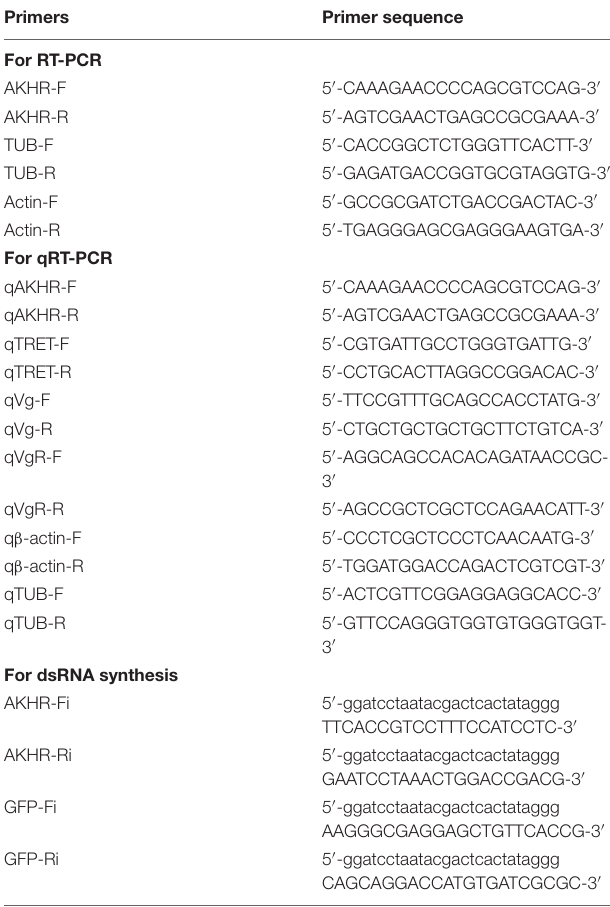
TABLE 1 | Primers used in this study. Primers Primer